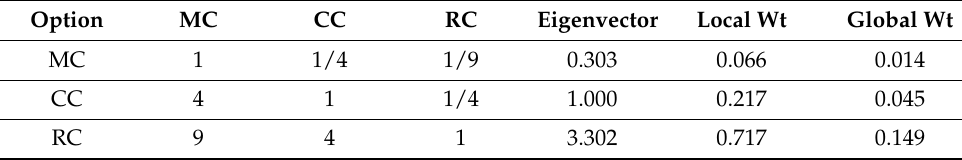
Table A5. Comparison of alternatives matrix for subcriterion SA1.